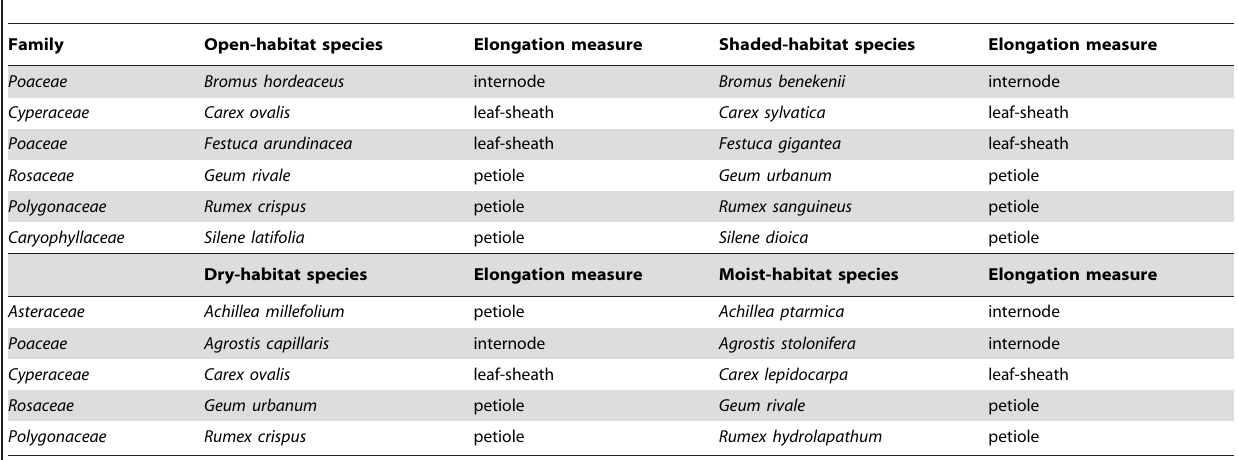
Table 1. Congeneric species pairs used in the study and their respective plant traits analysed for their elongation response.